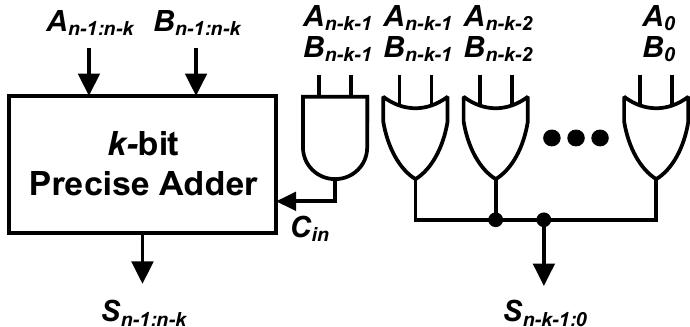
Figure 1. Architecture of lower-part OR adder (LOA).